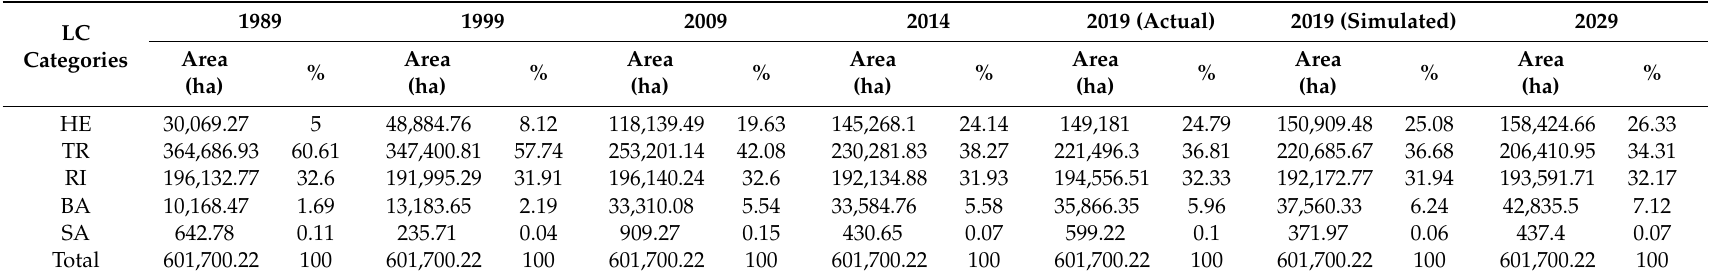
Table 2. Types of LC within the SRF from 1989 to 2019 presented in hectares and percentages, based on multi-temporal satellite